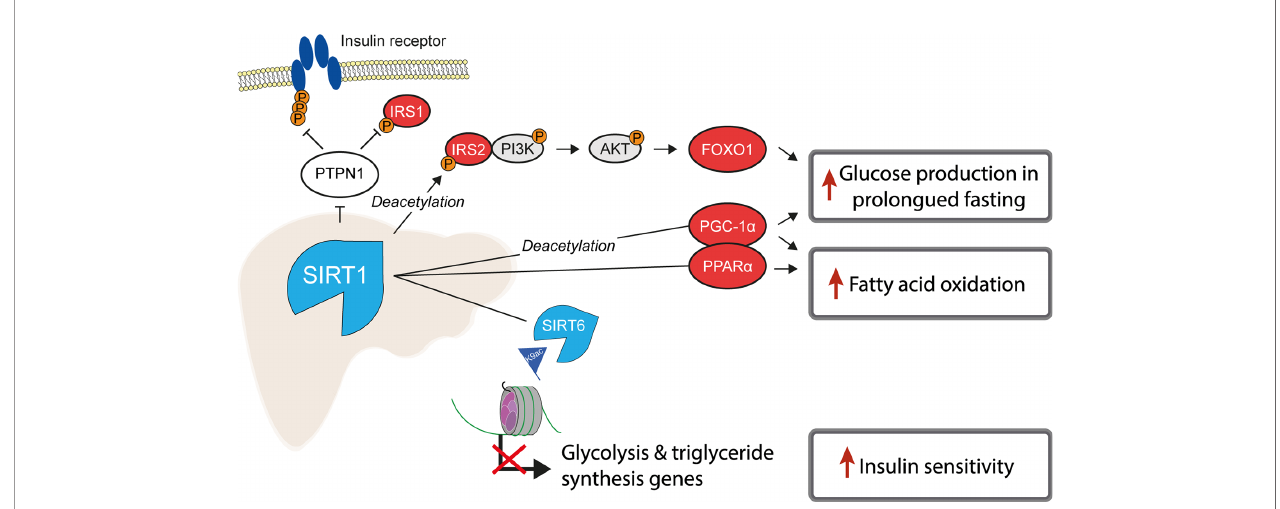
FIGURE 4 | SIRT1 is a master regulator of hepatic insulin sensitivity. Under normal conditions, the functions of the histone deacetylase SIRT1 include to increase fatty acid oxidation and glucose production, by deacetylating both histone and non-histone proteins, including several key transcription factors which regulate gluconeogenic and lipogenic gene expression. Non-histone targets of SIRT1 are labelled with “ Deacetylation ”